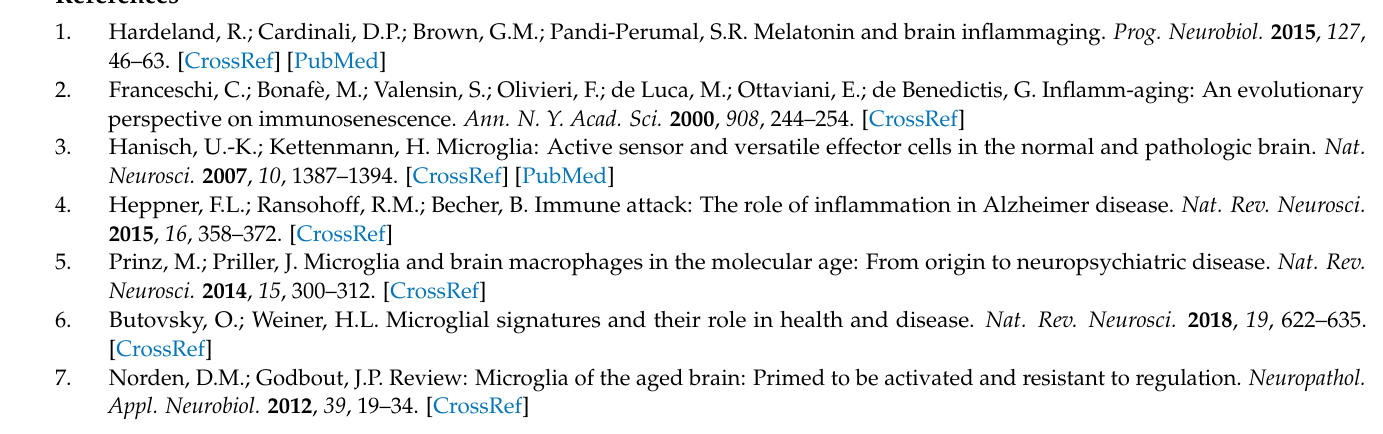
Table S1: Animal body